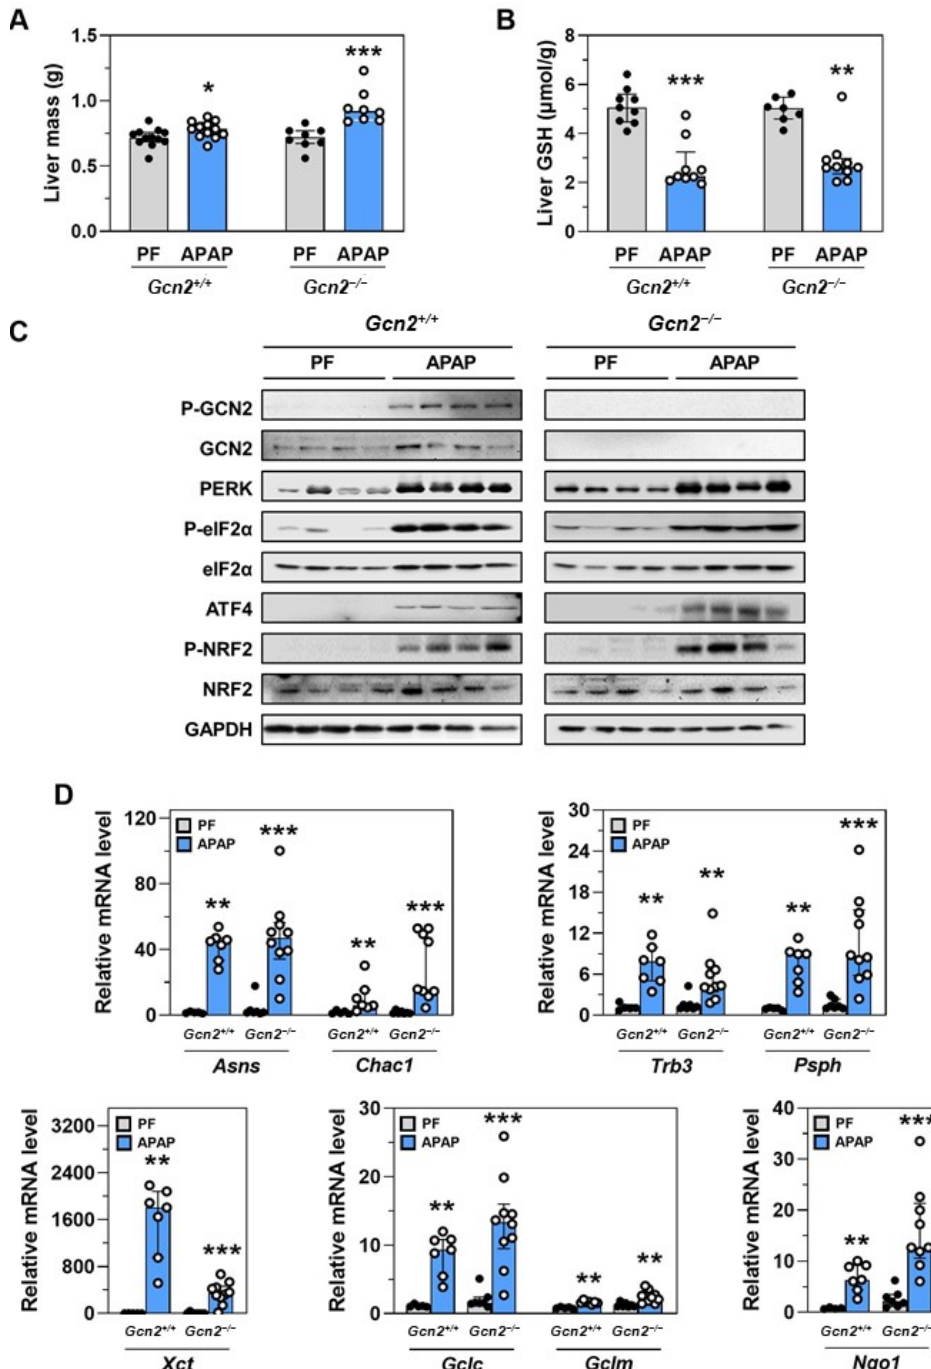
Figure 4. Impact of the absence of GCN2 in the APAP-induced up-regulation of the eIF2 α -ATF4 pathway in the liver. Gcn2 null ( Gcn2 − / − ) or positive mice ( Gcn2 +/+ ) were fed the APAP diet (APAP) for 18 d or were pair-fed (PF) the control diet to match the daily food intake of the respective APAP-treated mice. ( A ) Liver mass. ( B ) Total free GSH (GSH, GSSG, and other small disulfides) concentration in the liver. ( C ) Immunoblot analysis of phosphorylated forms (P-) of GCN2, eIF2 α , and NRF2, total GCN2, PERK and eIF2 α , ATF4, NRF2, and GAPDH. ( D ) Expression of a set of ATF4-dependent and Nrf2-dependent genes. Total RNA extracted from the liver was analyzed by reverse transcription-quantitative PCR (RT-qPCR). In ( A , B , D ) graphs, each bar shows the median with interquartile, and dots are individual values. * p ≤ 0.05; ** p ≤ 0.01; *** p ≤ 0.001 vs. respective PF; Mann Whitney